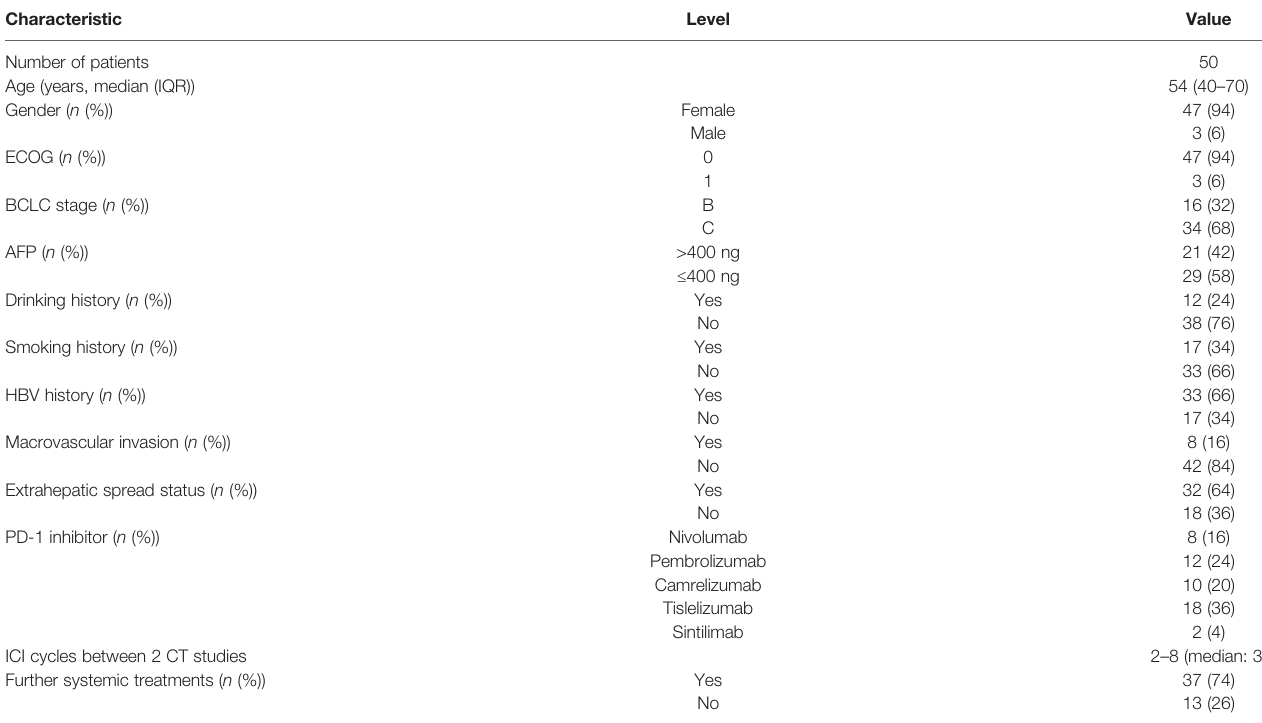
TABLE 1 | General characteristics of the patients, immunotherapy, and CT studies.